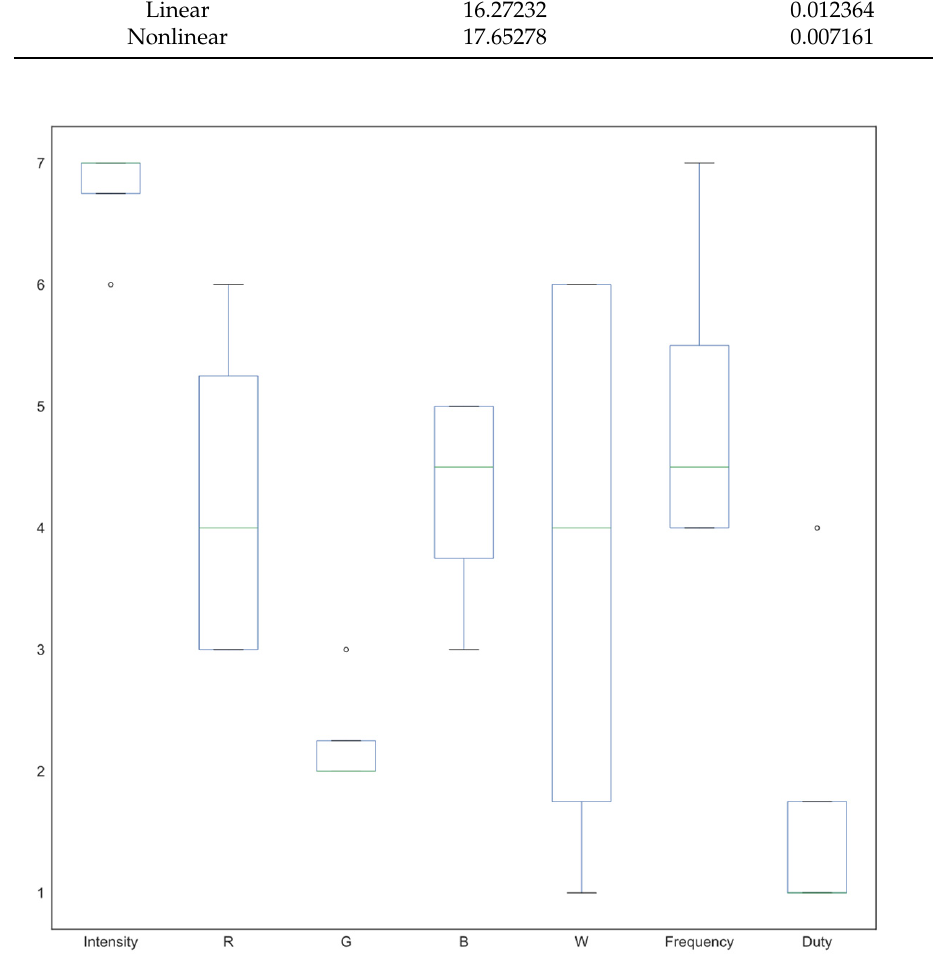
Figure 9. Order of elimination for features in linear models.